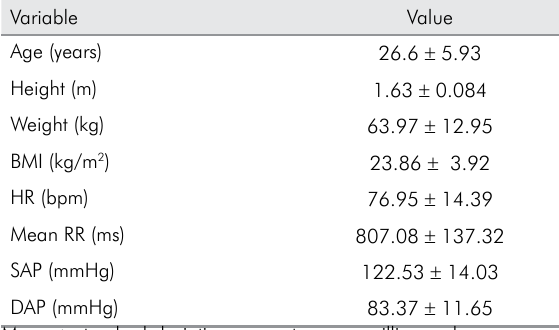
Table 1. Baseline diastolic (DAP) and systolic arterial pressure (SAP), heart rate (HR), mean RR interval, weight, height and body mass index (BMI) of the